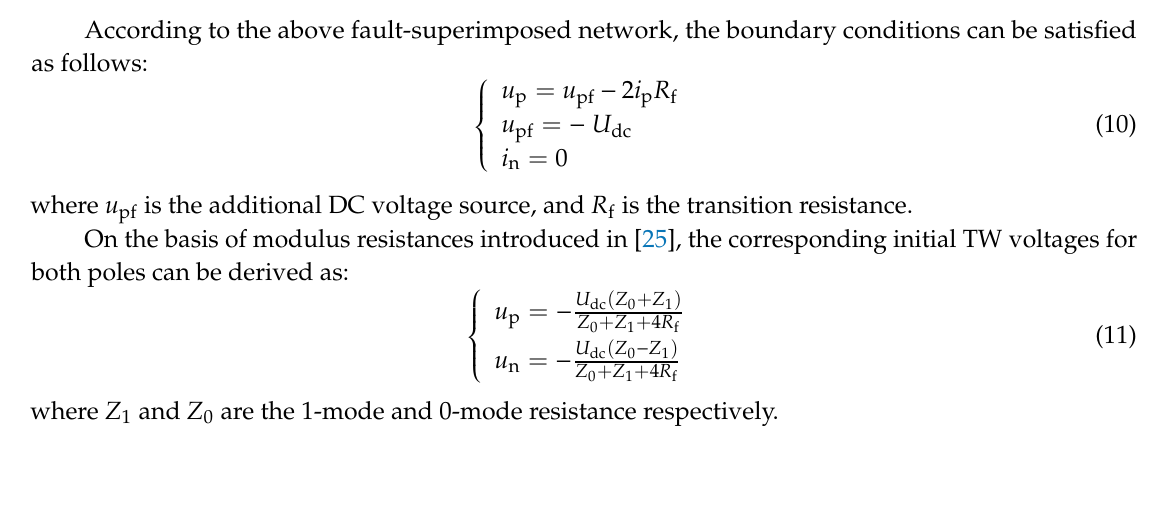
Figure 4. Positive pole ‐ to ‐ ground fault.